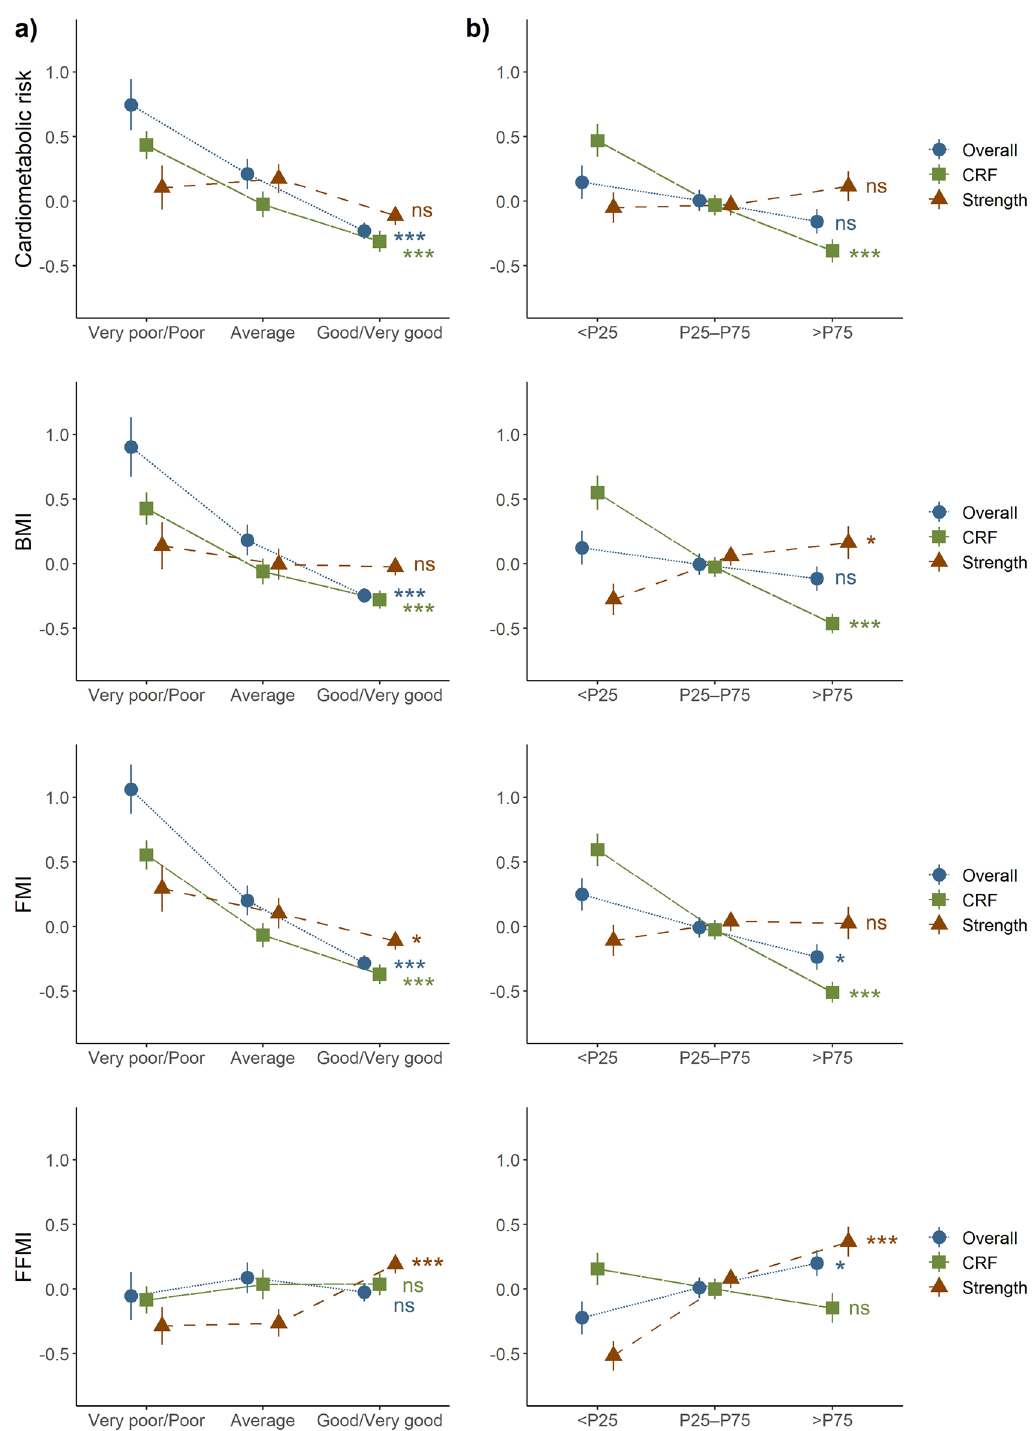
Figure 3. Relative differences in cardiometabolic risk score and body composition according to categories of ( a ) self-reported and ( b ) objectively measured physical fitness in early pregnancy. Measured fitness is split in percentiles indicating relative low (> P25), medium (P25-P75) and high (> P75) fitness levels. Mean and standard error bars using standardized z-scores (after log-transformation) are shown for each group and category. Overall fitness: self-reported overall fitness compared with a composite score computed as the average of the z-scores from the two different fitness tests, i.e., handgrip and 6-min walk test. CRF, cardiorespiratory fitness: self-reported CRF compared with 6-min walk test. Strength: self-reported muscular strength compared with handgrip test. BMI body mass index, FMI fat mass index, FFMI fat-free mass index. Significance level from the overall ANOVA test for each fitness type is indicated with symbols: ‘***’ p < 0.001, ‘**’ p < 0.01, ‘*’ p < 0.05, and ‘ns’,